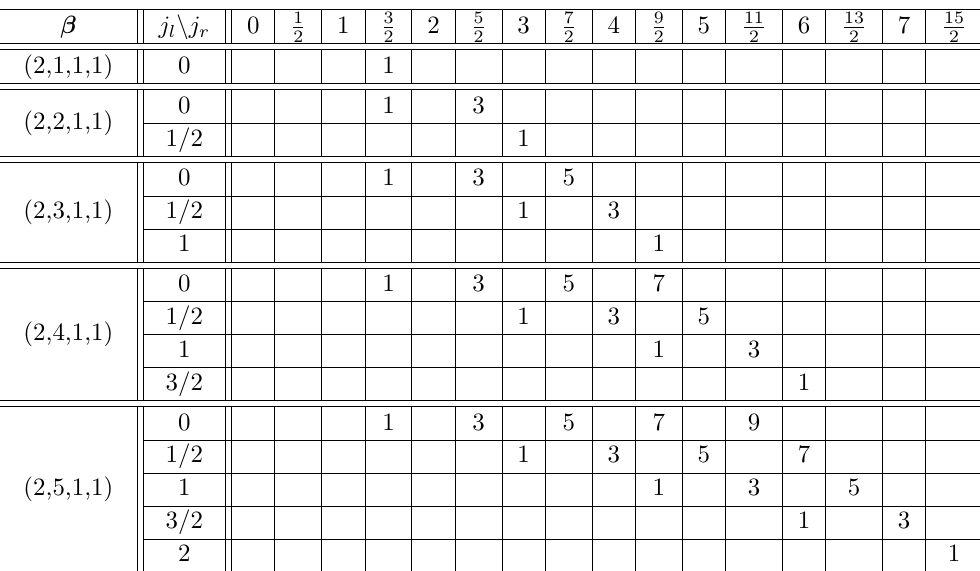
Table 3 . Refined GV invariants N β